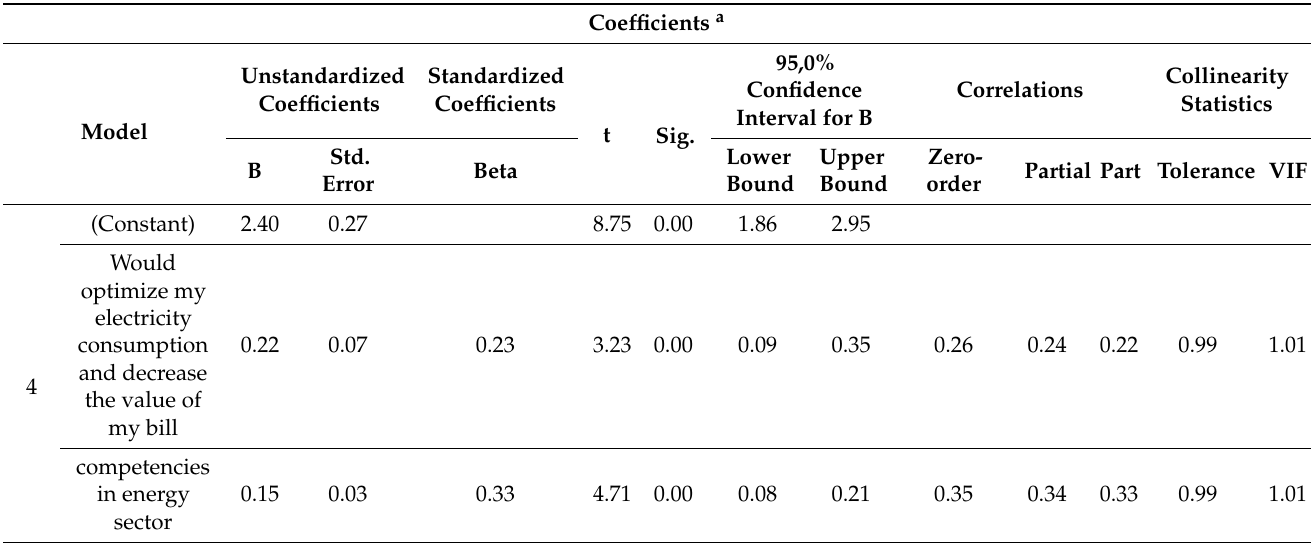
Table 9. Multiple linear regression: